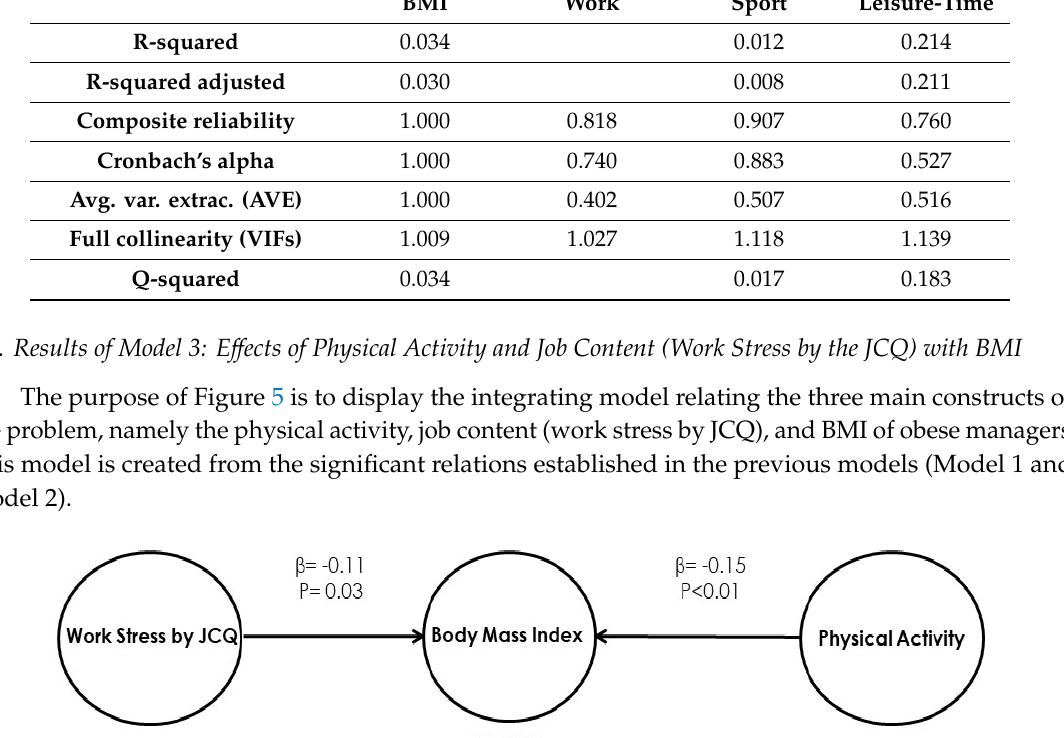
Table 7. Model 3. Direct effects of the relationships between work stress, physical activity, and BMI. Job Content ( Work Stress by JCQ )